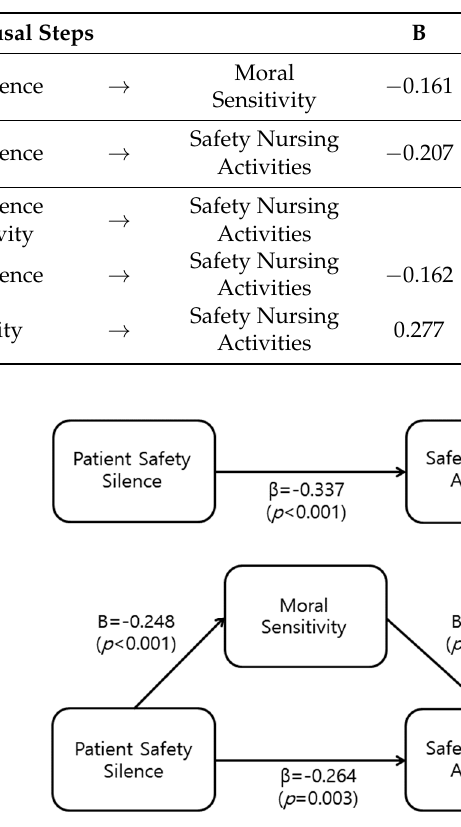
Table 4. Mediating effects of moral sensitivity on the relationship between patient safety silence and safety nursing activities (n = 120).